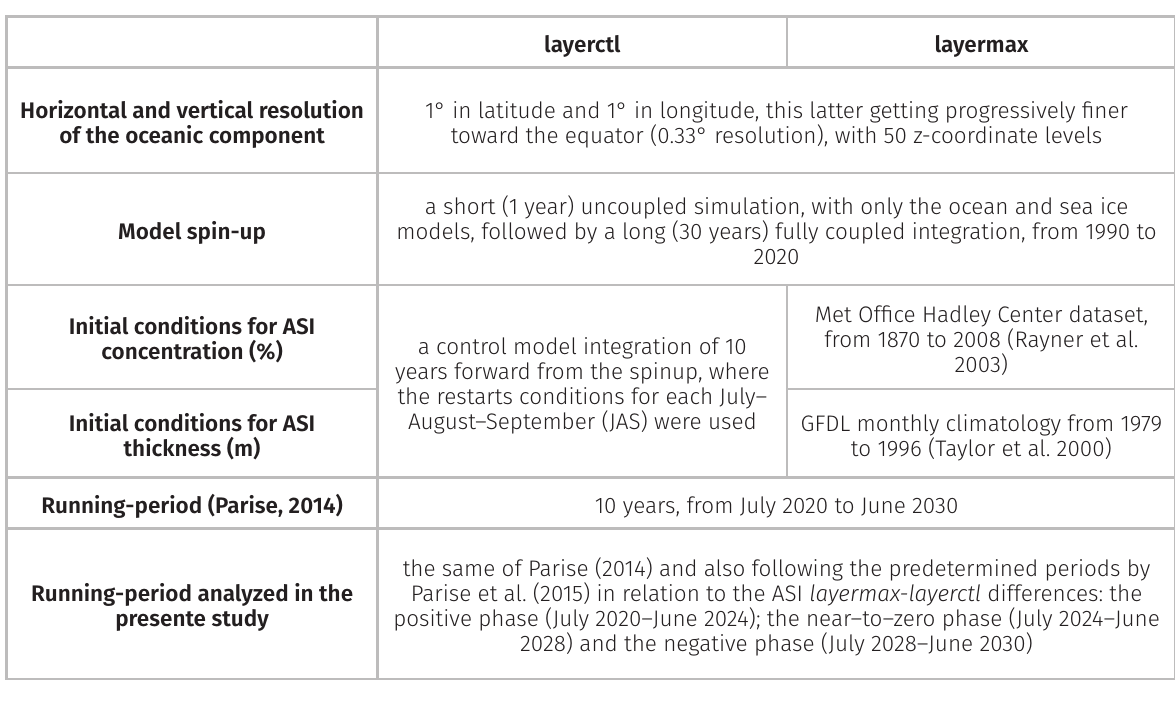
Table I. Schematic table with basic information on the sensitivity experiments performed with the CM2.1 model and used in this study, as a complement to that presented by Parise et al.